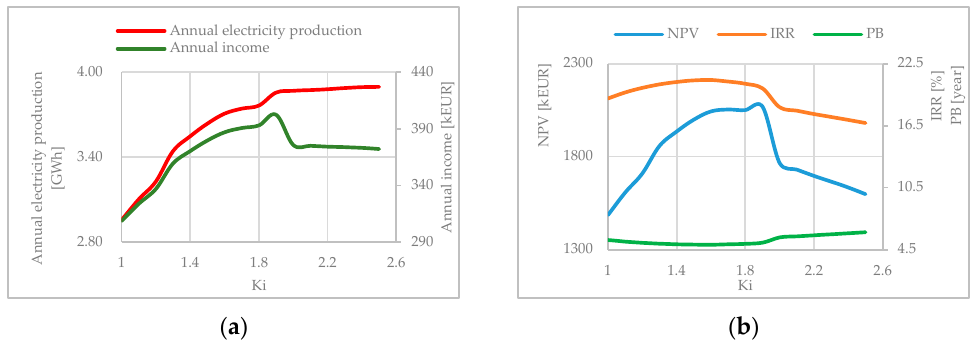
Figure 7. ( a ) Annual electricity production and income—Vrelo SHPP; ( b ) NPV, IRR, and PB—Vrelo SHPP.